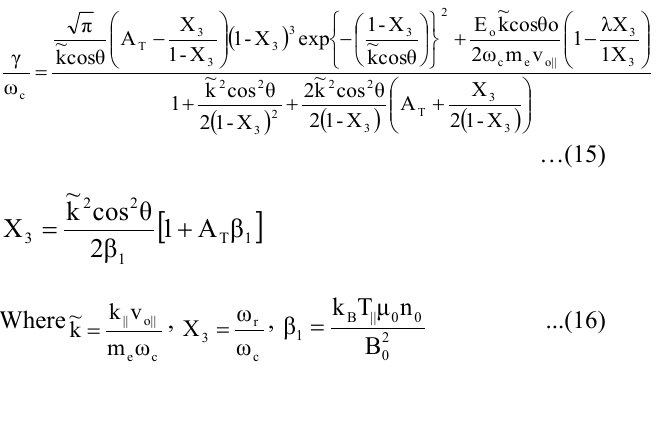
Fig.2: Variation of Growth Rate with respect to various values of at other plasma parameters being TT  || B o = 80nT, K B T || =400eV, n o =1x10 6 m -3 and